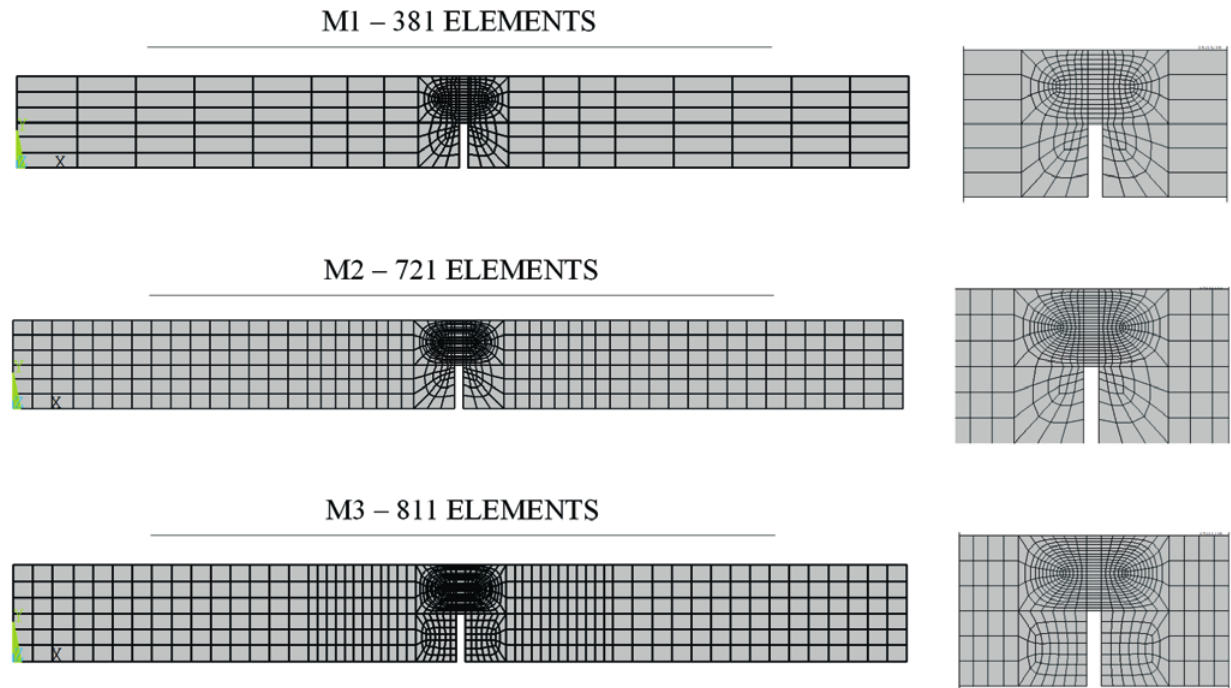
Figure 10 Discretization of the meshes with detail in the region of the notch - three-point bending